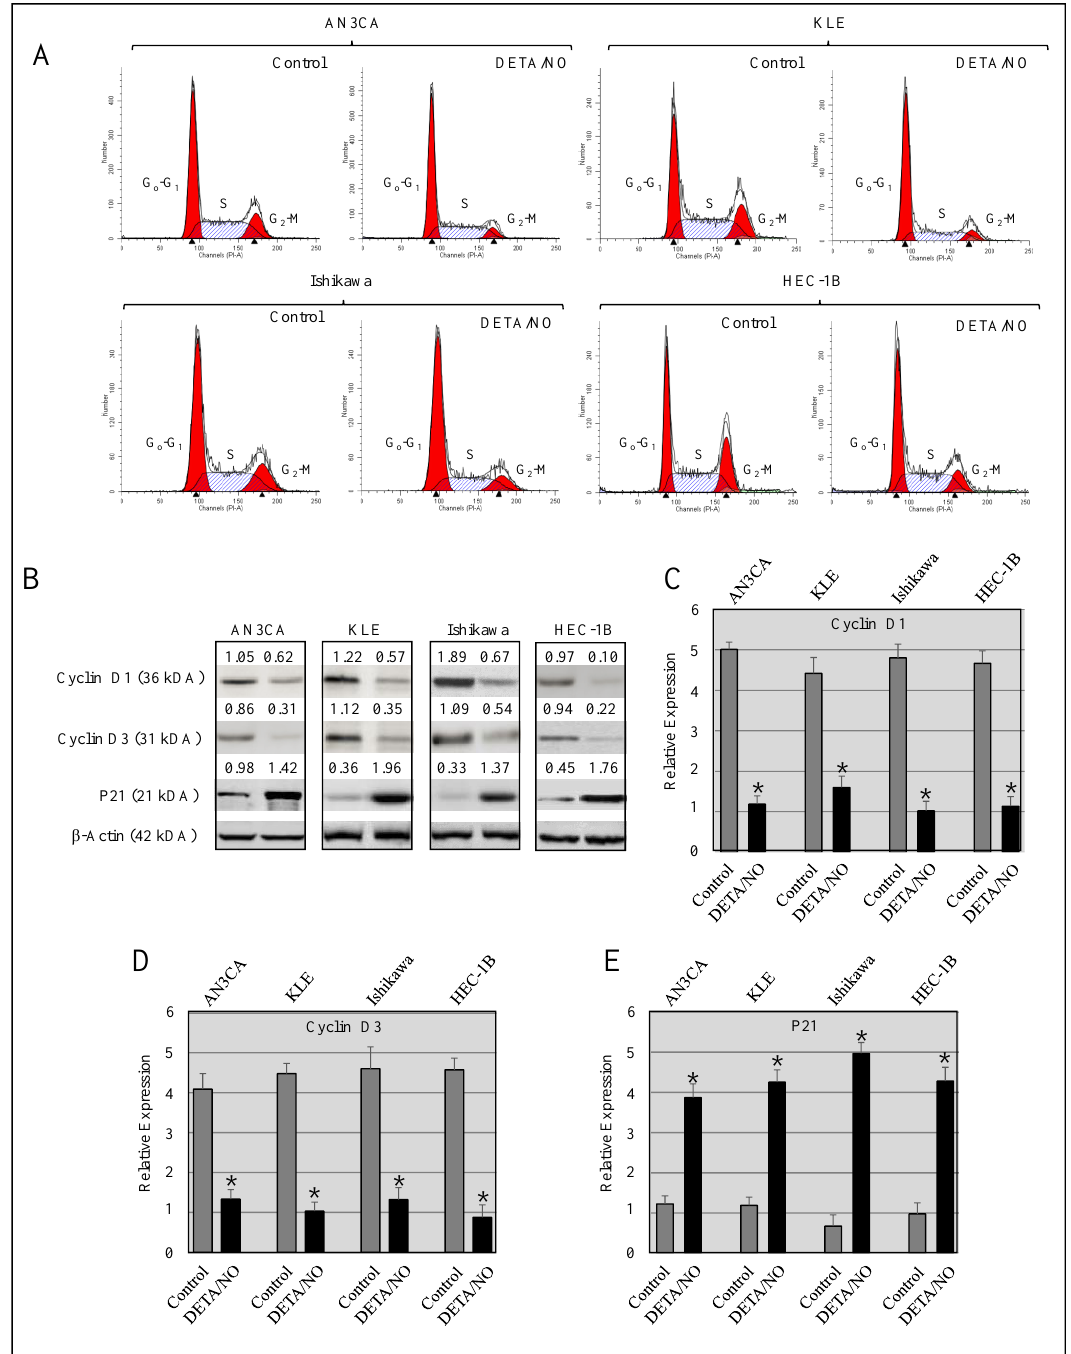
Figure 3. DETA / NO suppressed cell cycle progression. ( A ) Cells treated with DETA / NO for 24 h and stained with propidium iodide. DNA content was analyzed using flow cytometry. Results are shown as the percentage of cell population in G0-G1, S, and G2-M phases of the cell cycle. ( B ) Western blot analysis of cyclin D1, cyclin D3, and P21 in lysates of control and DETA / NO-treated cells. The values above the bands represent the relative density of the bands normalized to β -actin. ( C – E ) The expression of cyclin D1, D3, and P21 in DETA / NO-treated and vehicle-treated cells is shown as bars after normalization to β -actin. Data are expressed as means ± SEM of three independent experiments. An asterisk * ( p < 0.05) indicates a statistically significant change between control and treatment groups.